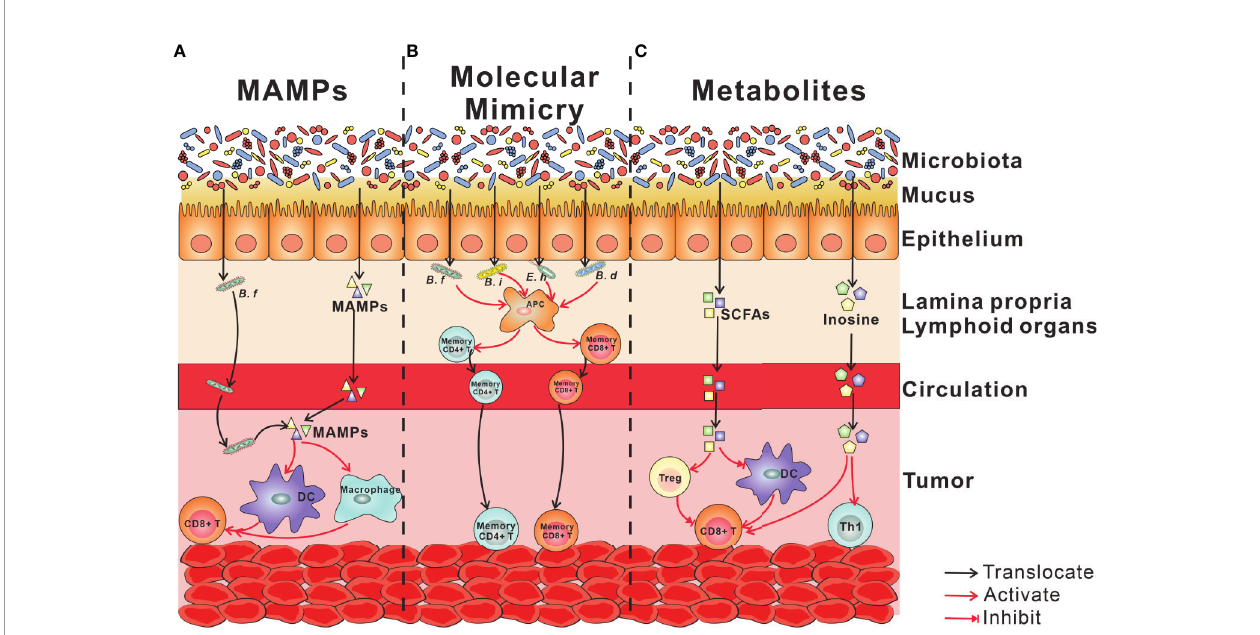
FIGURE 1 | Mechanisms linking gut microbiota with cancer immunotherapy. (A) MAMPs. Live bacteria ( Bi fi dobacterium facilitates ) and MAMPs traverse the mucosal barrier, enter the circulation, and fi nally locate at the tumor tissue, where MAMPs activate myeloid cells, including DCs and macrophages. The activation of myeloid cells enhances the phagocytosis of macrophages and cytotoxicity of CD8 + T cells downstream. (B) Molecular mimicry of microbial antigens with tumor neoantigen. Antigens of commensal bacteria, including Bi fi dobacterium facilitate , Bi fi dobacterium intestinihominis , Enterococcus hirae 13144, and Bi fi dobacterium breve , are presented by APCs to CD4 + T cells and CD8 + T cells. By circulations, antigen-speci fi c T cells arrive at tumor tissue and cross-react with tumor neoantigen. (C) Microbial metabolites. Microbiota-derived SCFAs play an immune-suppressive role in the tumor microenvironment via increasing the portion of Tregs, inhibiting DC maturation and CD8 + T-cell activation. Microbiota-derived inosine acts to advance Th1 differentiation and CD8 + T cytotoxicity. MAMPs, microbe-associated molecular patterns; DC, dendritic cell; APCs, antigen-presenting cells; SCFAs, short-chain fatty